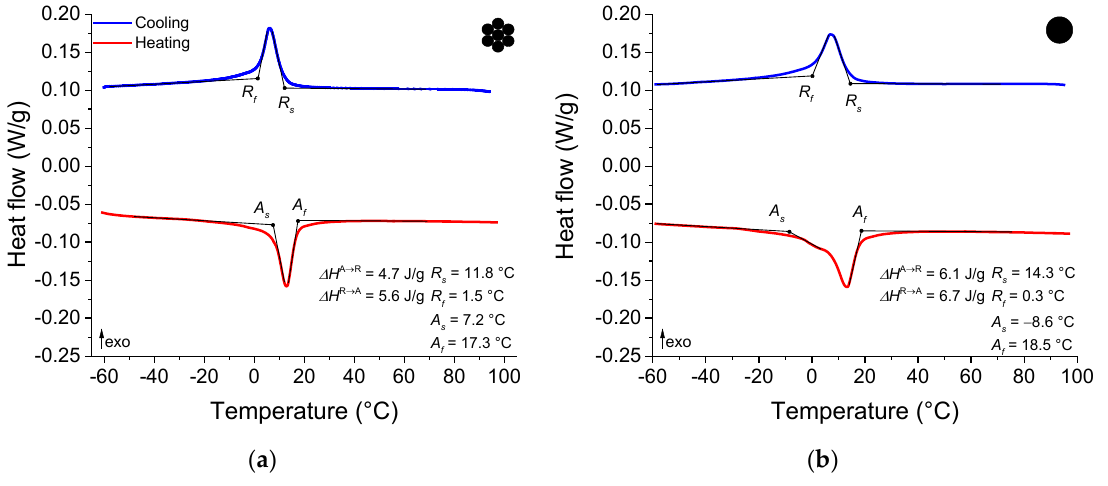
Figure 3 . Thermal behavior characterized by DSC. ( a ) NiTi SMA micro cable. ( b ) Reference element.